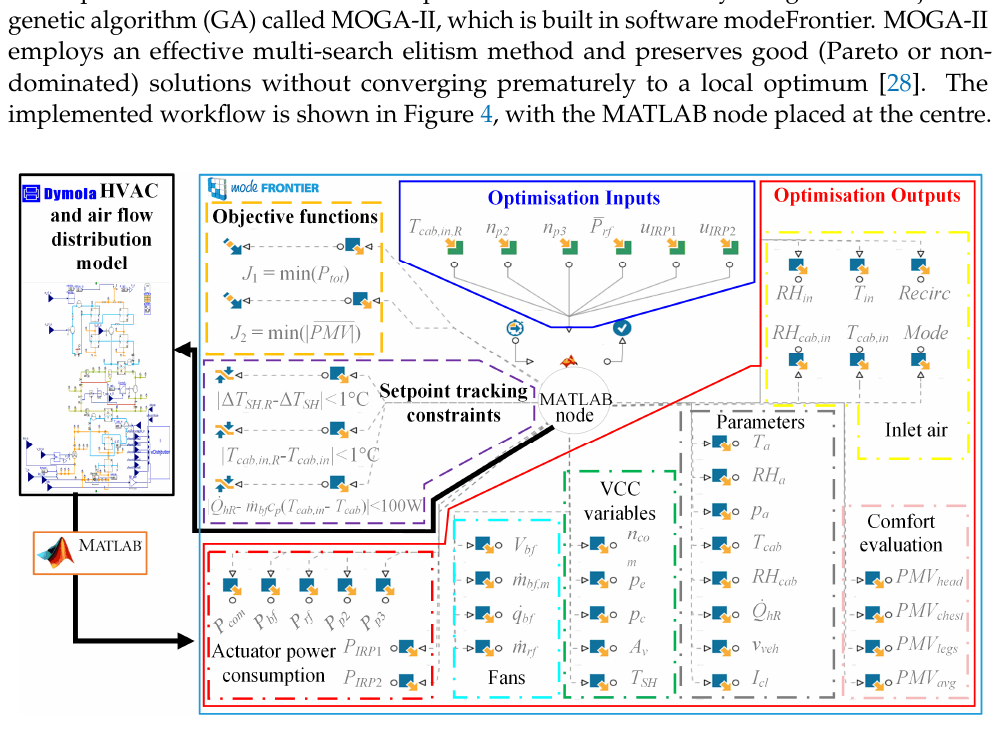
Figure 4. Optimisation framework implemented within ModeFrontier